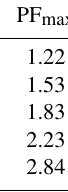
periods for the 2021 event. It also indicates the need